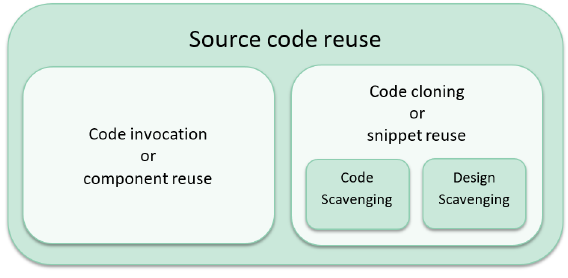
Fig. 1. Source code reuse